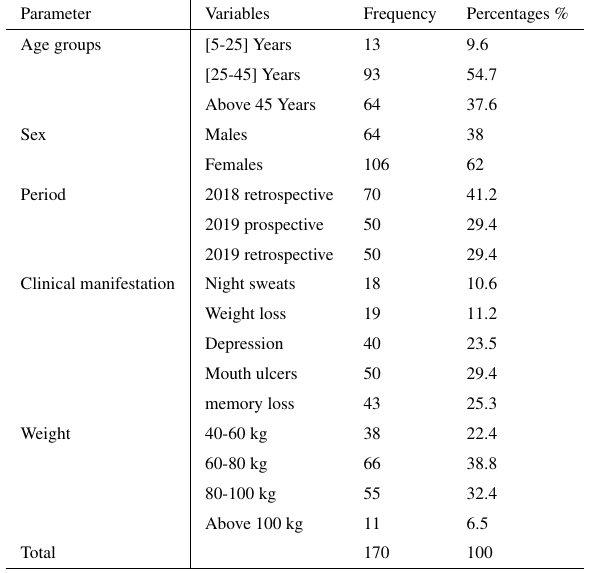
Table 1. Number of patients participated in the study and their corresponding gender, age, clinical manifestation, weight and period. Parameter